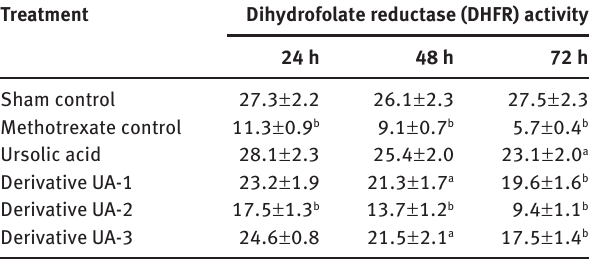
Table 2 Effect of ursolic acid and its novel synthesized